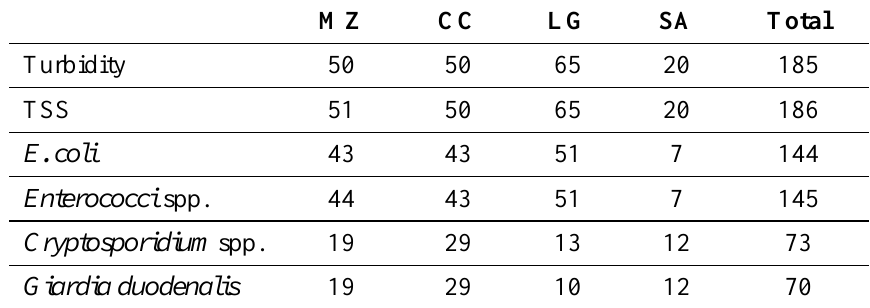
Table 5. Total Number of Samples Collected per Analyte for Montezuma (MZ),